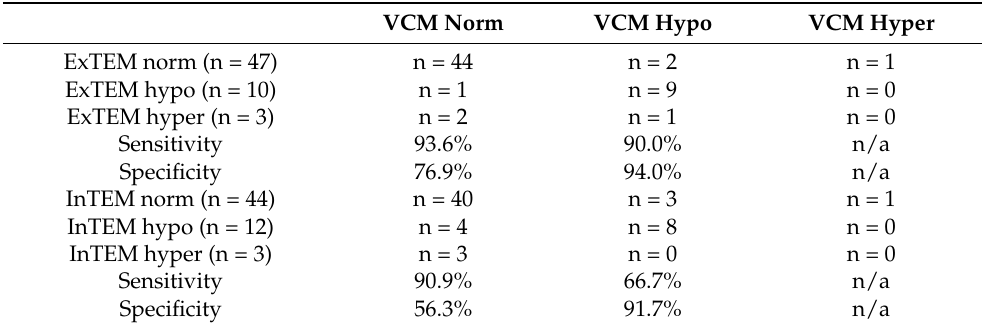
Table 5. Cross table presenting the agreement of different coagulation states between ROTEM and VCM (ROTEM as the reference